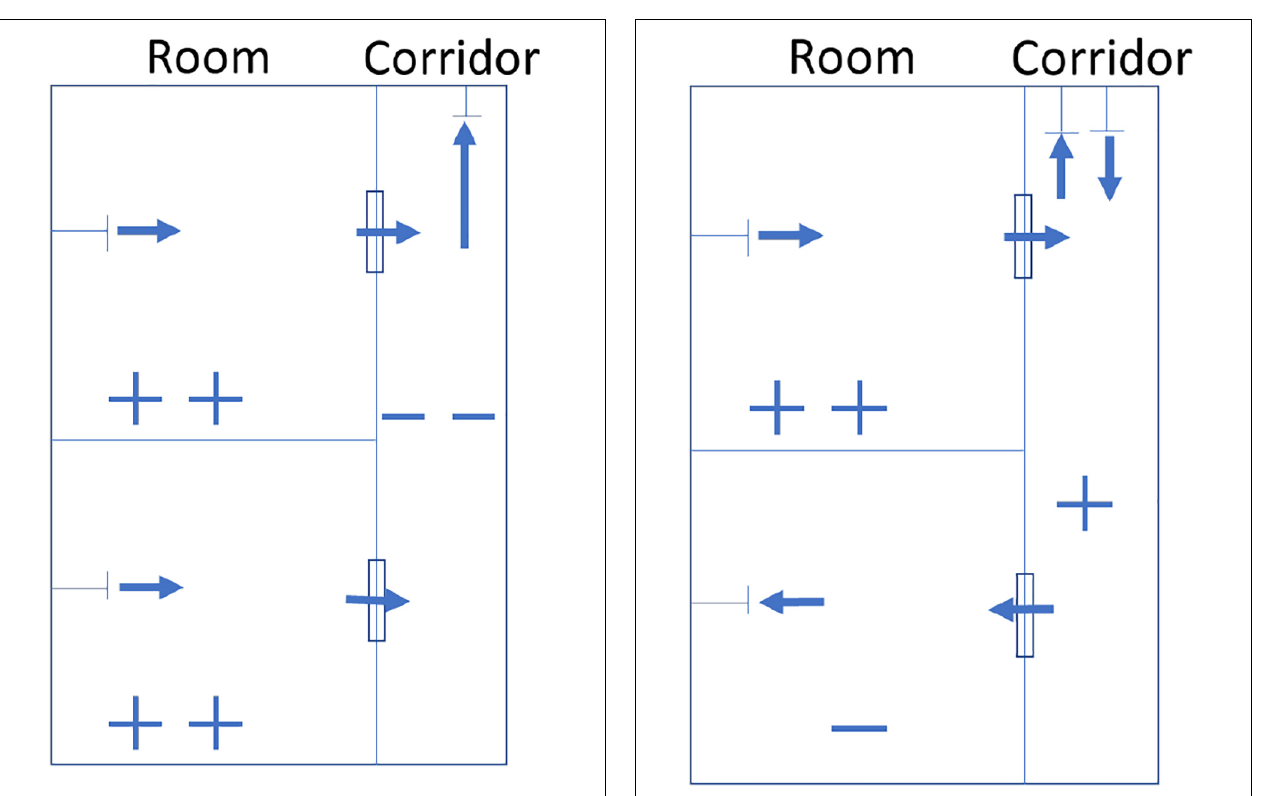
FIGURE 3 | Directed airflow with relative internal pressure for two rooms and a corridor; (+) is positive pressure (higher pressure), (–) is negative pressure (lower pressure), and ( → ) denotes